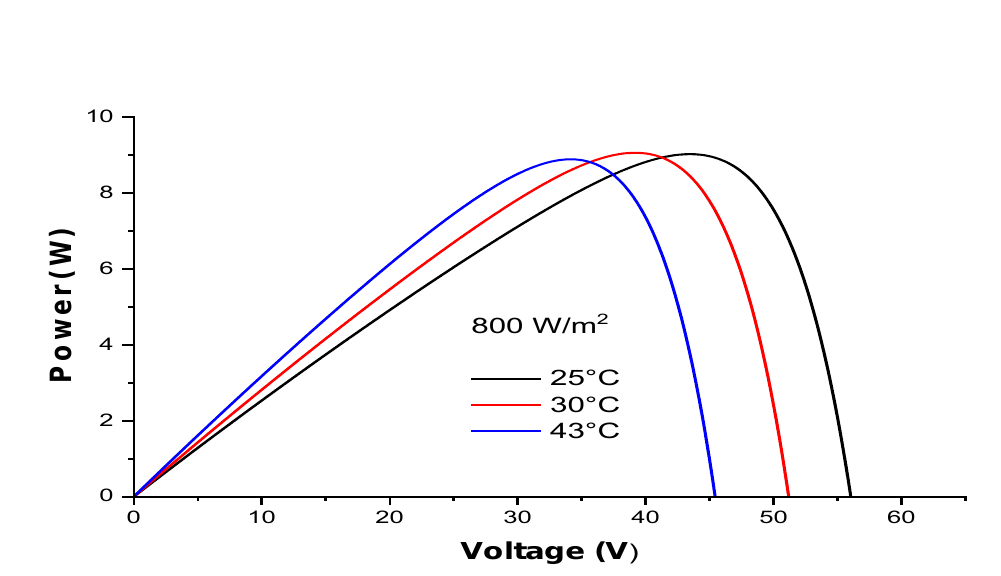
Figure 6. P-V curve showing the effect of